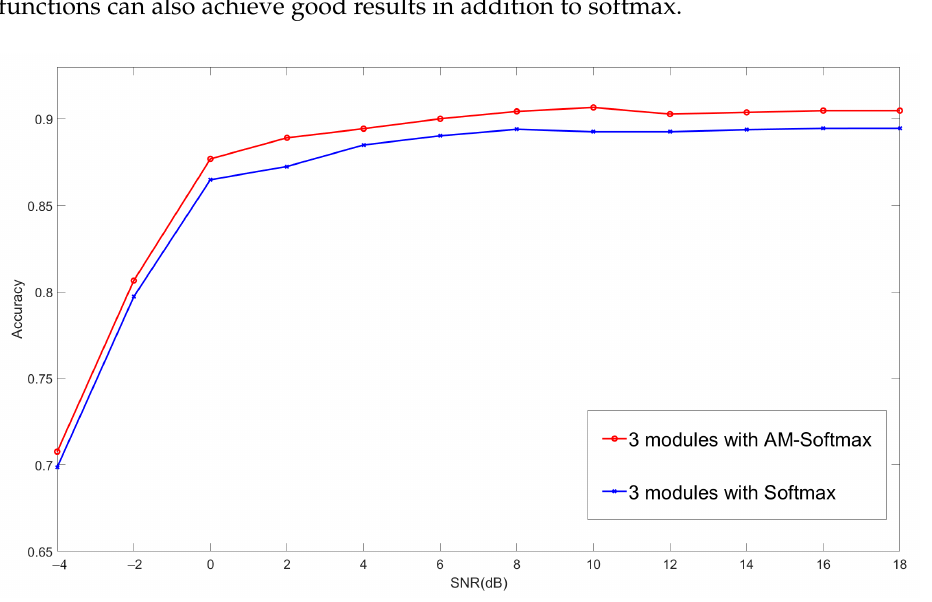
Figure 10. The comparison between AM-softmax and